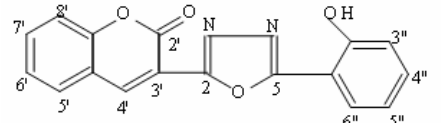
Figure 2 . 2-(Chromen-3'-onyl)-5-(2"-hydroxy phenyl)-1,3,4-oxadiazole (L2); m.p. 310º